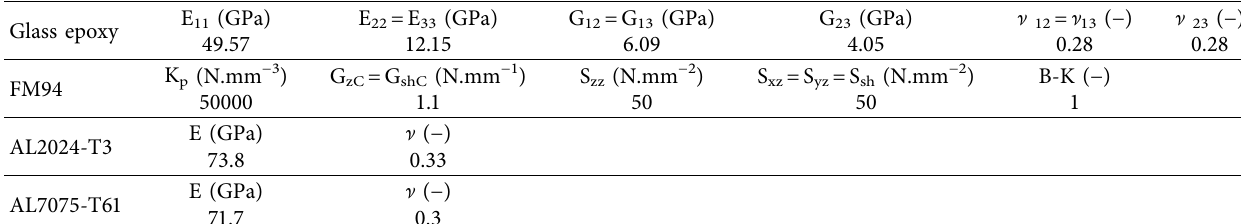
Figure 2: Delamination positions at Interface 1 and Interface 2. Table 3: Properties of materials used in GLARE constituents